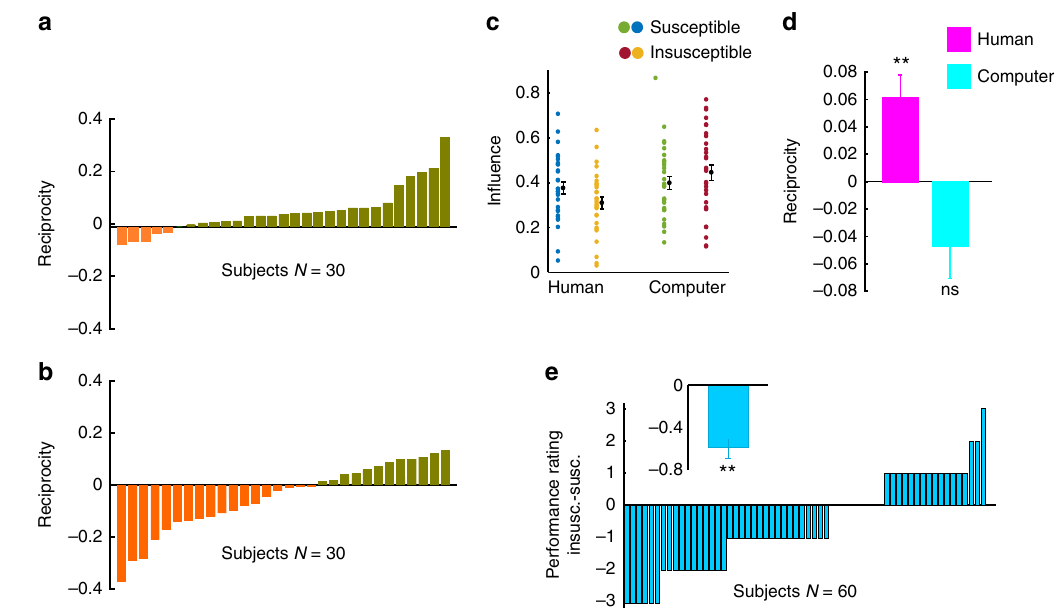
Fig. 3 Results of experiments 2A and 2B. a Reciprocity when participants believe they interact with a human partner. b Reciprocity when participants believe they interact with a computer partner. c In fl uence for alleged human and computer partners across susceptible and insusceptible conditions. Dots indicate each participant. Black dots depict the mean in fl uence across participants while error bars depict the standard error of the mean. d Average reciprocity across participants when participants think they interact with a human or a computer partner. Error bars depict the standard errors. e Difference in participants ’ performance rating for self, insusceptible minus susceptible, plotted for each participant. The inset shows the mean and standard error across participants. ** p < 0.005, ns not signi fi cant; Wilcoxon sign rank